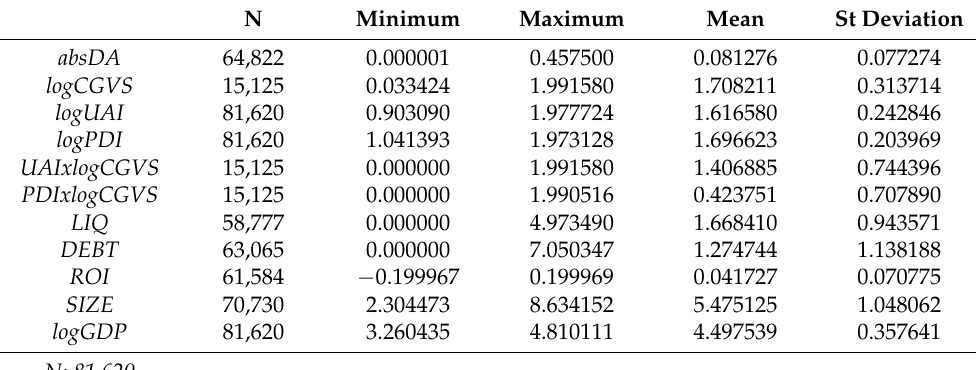
Table 3. Descriptive statistics for variables in Equation (1).